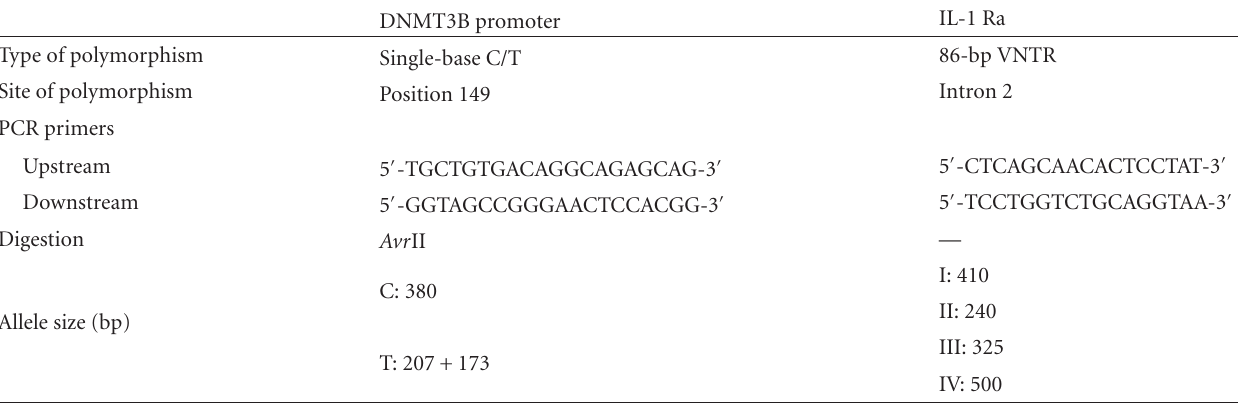
Table 1: Allele types, PCR conditions, and PCR primers designed to amplify fragments harboring the polymorphic sites.